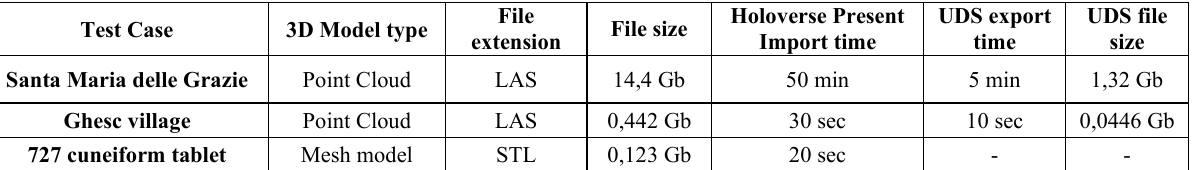
Table 4 . 3D model management pipeline data.